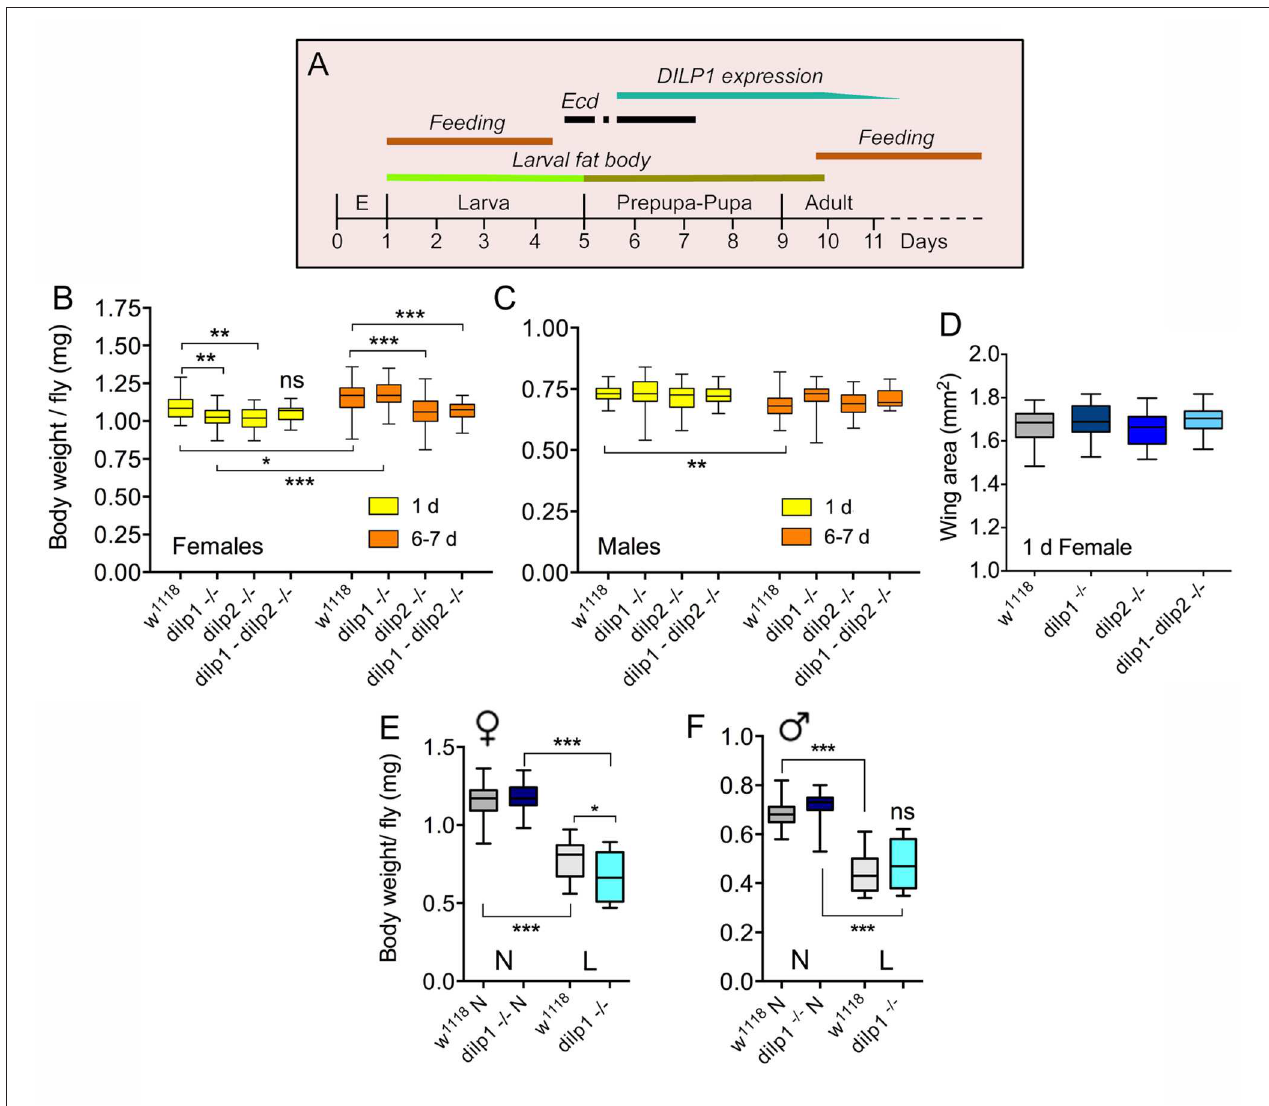
FIGURE 1 | dilp1 mutant flies display reduced body weight, but are not smaller. (A) Expression profile of dilp1 /DILP1 in Drosophila . Note that expression of transcript and peptide coincides with the non-feeding pupal stage and the first days of adult life when food intake is reduced (especially day one). It also times with the onset of the second and third ecdysone ( Ecd ) surges in the early pupa (earlier ecdysone peaks are not shown). E, embryo. (B) Body weight of female flies 1 day and 6–7 days after adult eclosion. dilp1 mutant flies display reduced body weight when 1 day old, but gain substantially the first week. Also, dilp2 mutants weigh less, but do not gain much weight the first week. The double mutants are not significantly affected compared to controls at 1 day, but after 6–7 days, both dilp2 and double mutants weigh less that controls and dilp1 mutants. Data are presented as medians ± range, n = 25–30 flies for each genotype from three independent replicates (* p < 0.05, ** p < 0.01, *** p < 0.001, ns, not significant; two-way ANOVA followed by Tukey’s test). (C) In male flies, the three mutants display weights similar to controls and controls lose weight the first week. Data are presented as medians ± range, n = 18–30 flies for each genotype from three independent replicates (** p < 0.01, two-way ANOVA followed with Tukey’s test). (D) Wing area was used as a proxy for organismal growth. The three mutants did not display altered wing size. Data are presented as medians ± range, n = 16–23 flies for each genotype from three independent replicates (one-way ANOVA followed with Tukey’s test). (E,F) Body weight of 7-day-old flies that had been exposed to normal diet (N) or low protein diet (L) during late larval stage. The female dilp1 mutant flies displayed lower body weight than controls after low protein. Data are presented as medians ± range, n = 17–29 flies for each genotype from three replicates (* p < 0.05, *** p < 0.001, one-way ANOVA followed by Tukey’s